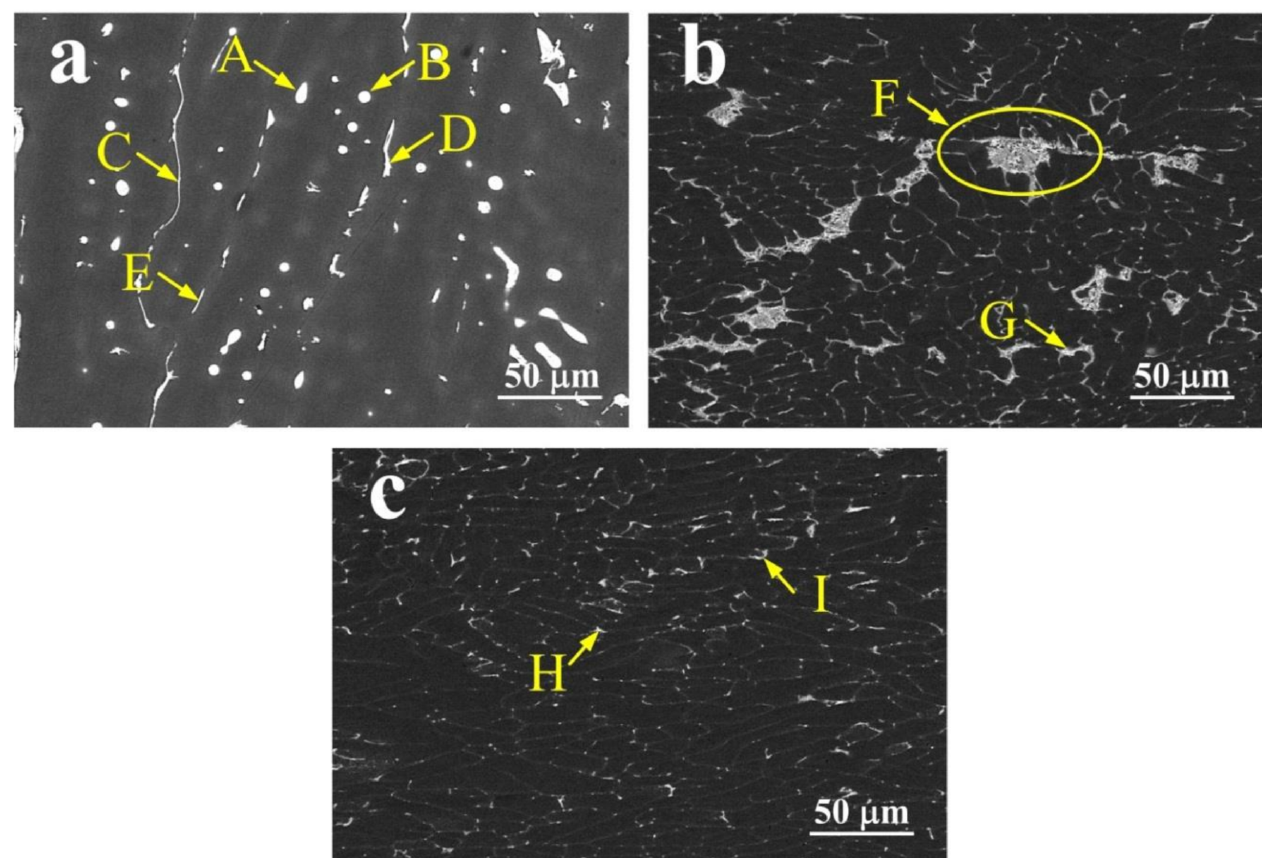
Figure 4. Microstructures of eutectic phases in Al-Cu-Li alloys: ( a ) ingot; ( b ) TRC plate; ( c ) electromagnetic TRC plate. Table 2. EDS spectrum analysis of the eutectic phases in Al-Cu-Li alloys.